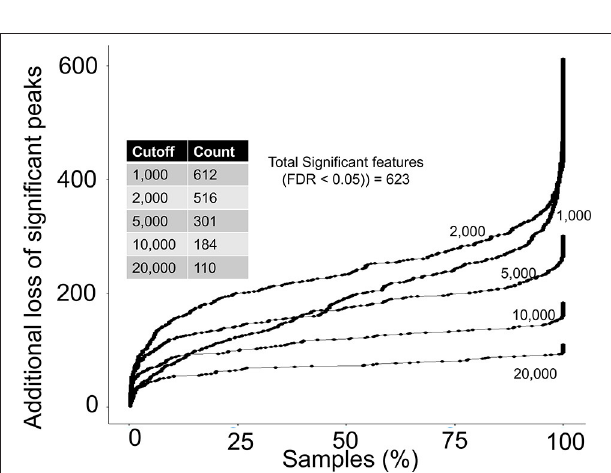
FIGURE 4 | Rejection of biological relevant peaks by peak height and detection frequency thresholds. For each peak height threshold (1,000, 2,000, 5,000, 10,000, and 20,000), a count of total peaks that were associated with birth weight are shown in the inside table. Y-axis shows the additional loss of peaks as a function of detection frequency cutoffs. For example, at a detection frequency cutoff of 50% and peak height cutoff of 10,000, additional 100 significant peaks will be lost, yielding retainment of only 84 peaks.